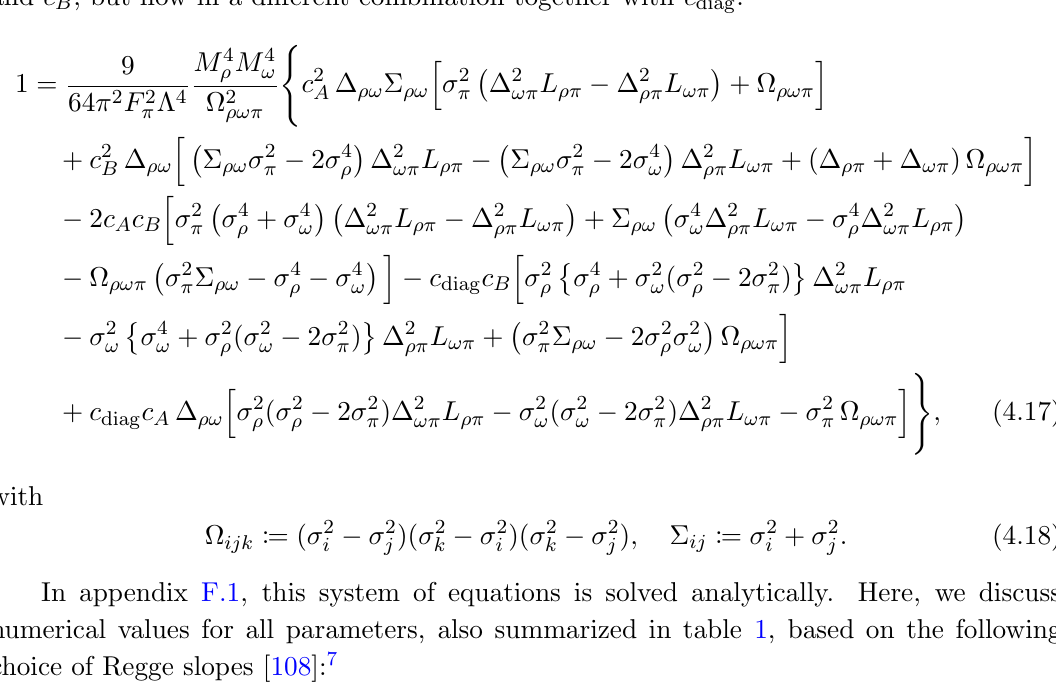
= N . (cid:30)! = Q 2 ! 1 , for all i = 1 ; 2 ; 3. It also involves c A i diag